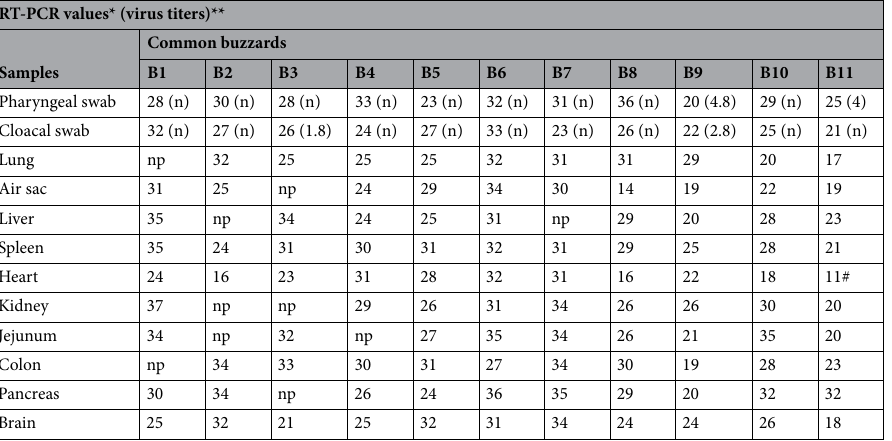
Table 1. RT-PCR of the influenza A virus matrix gene-fragment results and virus titers in swabs and organs of H5N8-infected wild Common buzzards ( Buteo buteo ). *Cycle threshold (Ct) value, cut-off value is 40; ** all titers are given in TCID 50 log 10; # this value is likely an outlier; n, negative (< 0.5 for virus titers); np, not